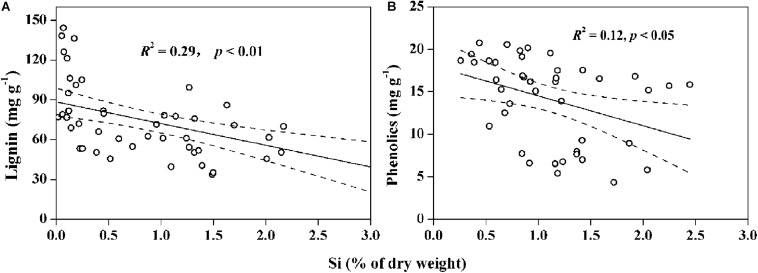
Negative correlations between (A) content of silicon (Si) and lignin in wetland plants (data collected from Schoelynck et al., 2010; Schaller et al., 2012; Suzuki et al., 2012), and (B) content of Si and phenolics in dryland plants (data collected from Frew et al., 2016; Johnson and Hartley, 2018). Solid lines represent the significant correlations, and the dashed line regions represent 95% confidence intervals.